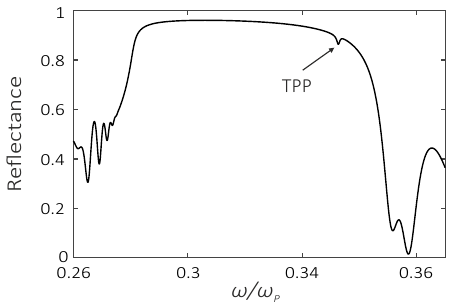
Figure 12. Reflectance spectra of the structure for the radiation incident from the nanocomposite layer side. d eff = 341 nm and f = 0.25.